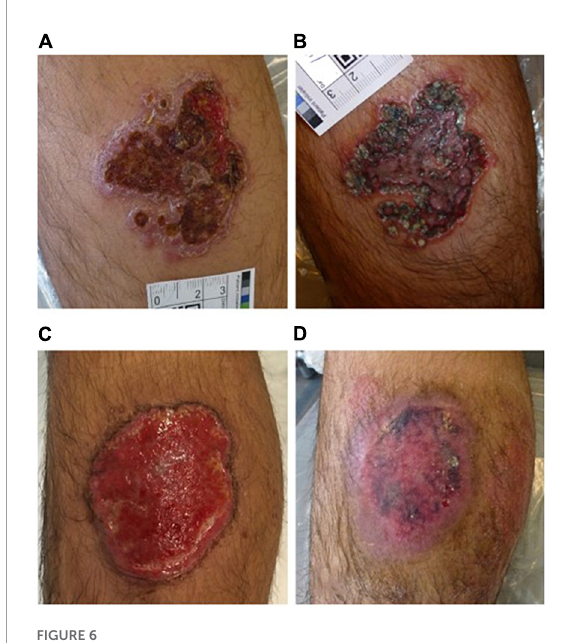
FIGURE6 Effective treatment with PDT of cutaneous leishmaniasis. (A) Original lesion before treatment, (B) after oral fluconazole and topical ketoconazole, (C) after 12 PDT treatments, (D) 1 month after PDT treatment (figure adapted from the reference 116 with permission of John Wiley and Sons).